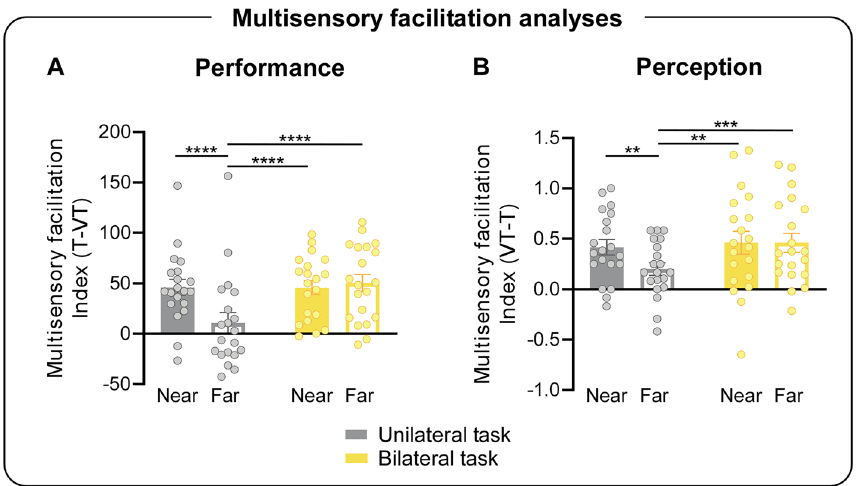
Figure 3. Multisensory facilitation analyses results, task × condition interaction. Bars represent the mean Multisensory facilitation Index [( A ) Performance ; ( B ) Perception ] in Near and Far conditions. Note that, for both measures, higher values indicate greater multisensory facilitation. Error bars indicate standard error of the mean (SEM). Dots represent individual participants. ****p < 0.0001; ***p < 0.0005, **p <